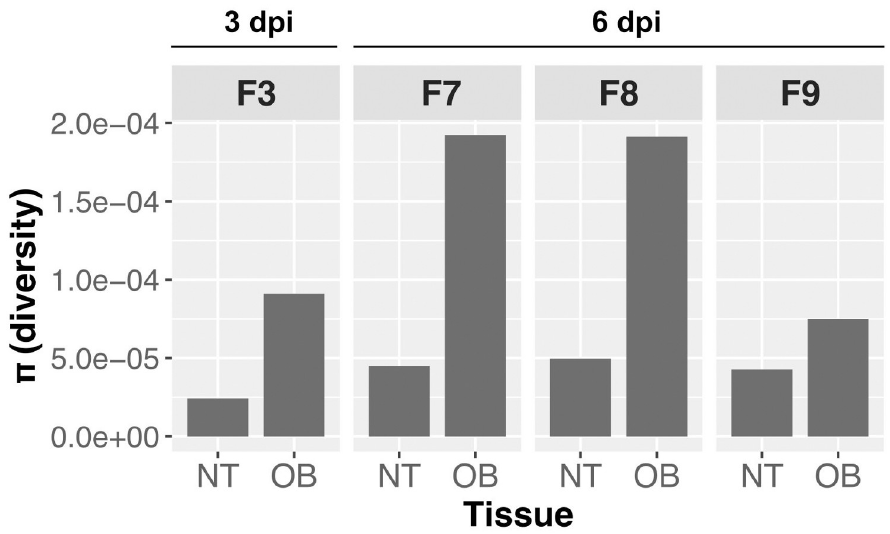
Fig 5. Absence of bottleneck for H5N1-WT virus entering the CNS via the olfactory nerve. H5N1-WT-virus infected ferrets show higher overall diversity in the olfactory bulb (OB) than in the nasal turbinate (NT).